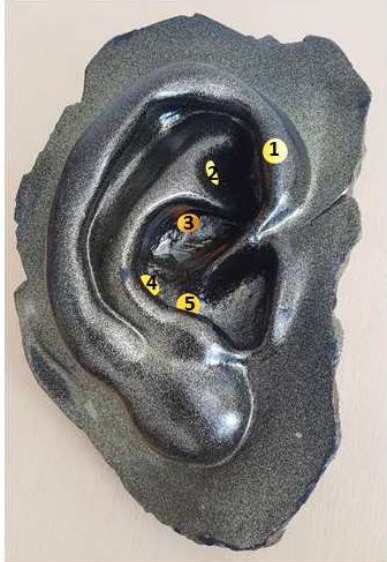
Figure 1. NADA auricular points (schematically): (1) Sympathetic, (2) Shen Men, (3) Kidney, (4) Liver, (5) Lung.